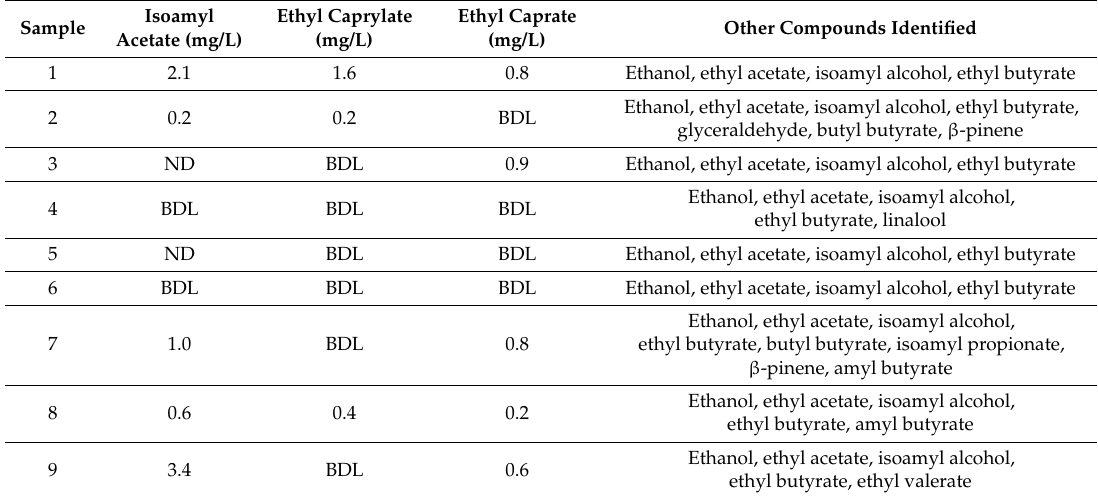
Table 5. Concentrations of common ester compounds and other compounds